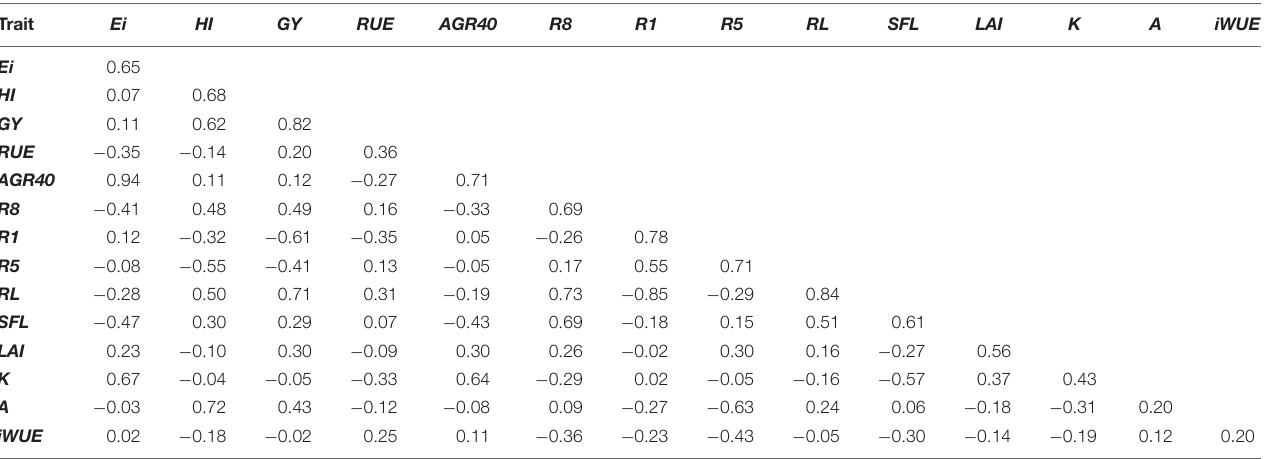
TABLE 2 | Additive–genetic correlation and narrow-sense heritability (diagonal) from a multitrait mixed model for physiological and phenological variables in a maturity-controlled panel of soybean.